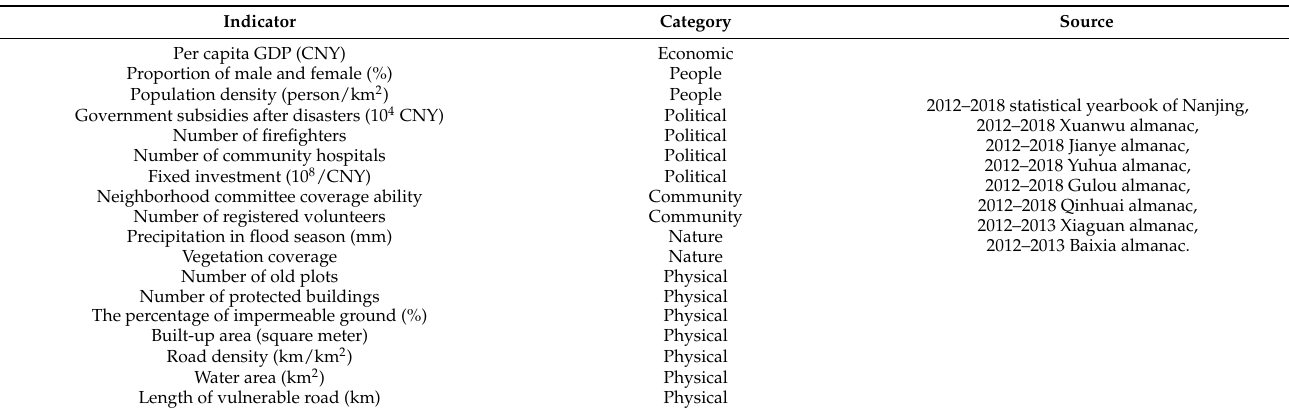
Figure 2. Overall study scheme. Table 1. Indicators of urban flood vulnerability.